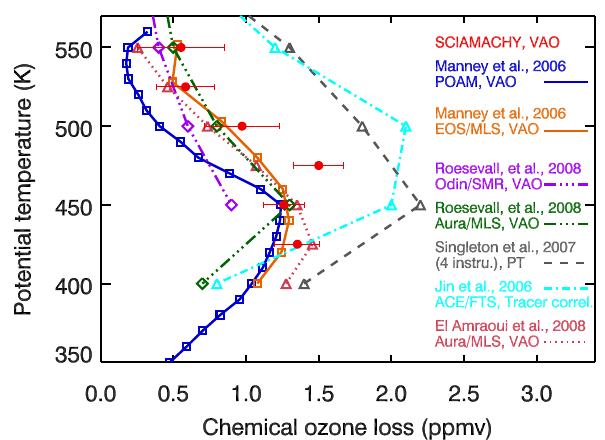
Fig. 14. Comparison of the vertical variation of the chemical ozone loss in the 2004/2005 Arctic polar vortex derived in different studies and based on different time periods. The periods investigated are: January 5 to March 10 for SCIAMACHY and Manney et al. (2006); January 1 to March 14 for R¨osevall et al. (2008); December 1 to mid-March for Singleton et al. (2007); January 1-7 to March 8-15 for Jin et al. (2006); January 10 to March 10 for El Amraoui et al. (2008).